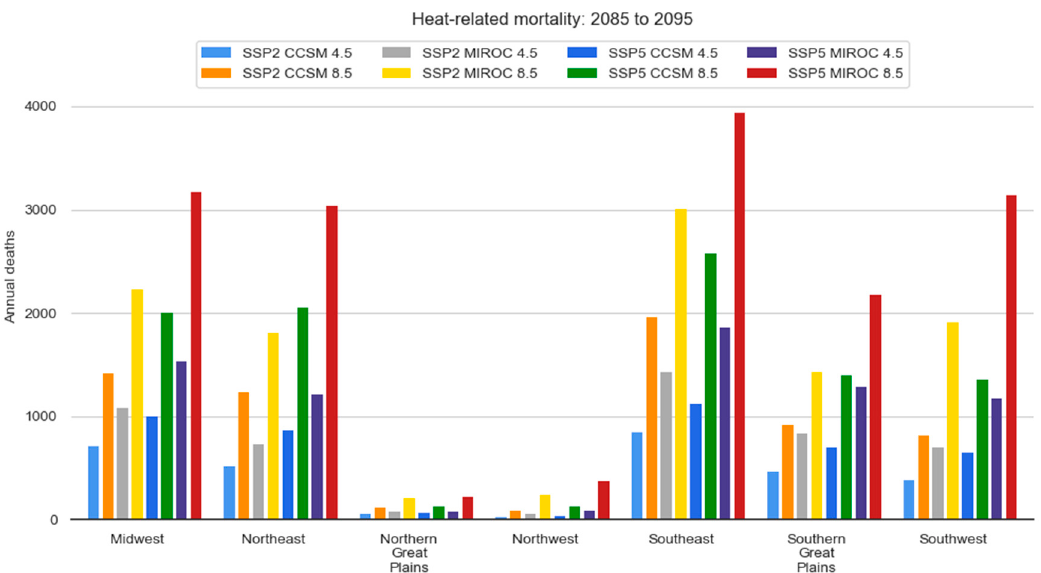
Figure 7. Regional modeling results by combination of population scenario, climate model, and emissions scenario.